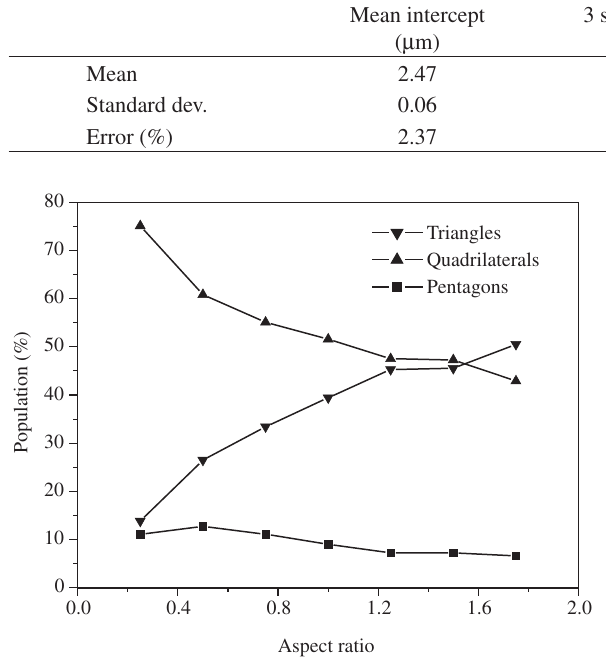
Figure 6. Number of 3 -, 4 - and 5 - sided intersection figures vs. the aspect ratio of the